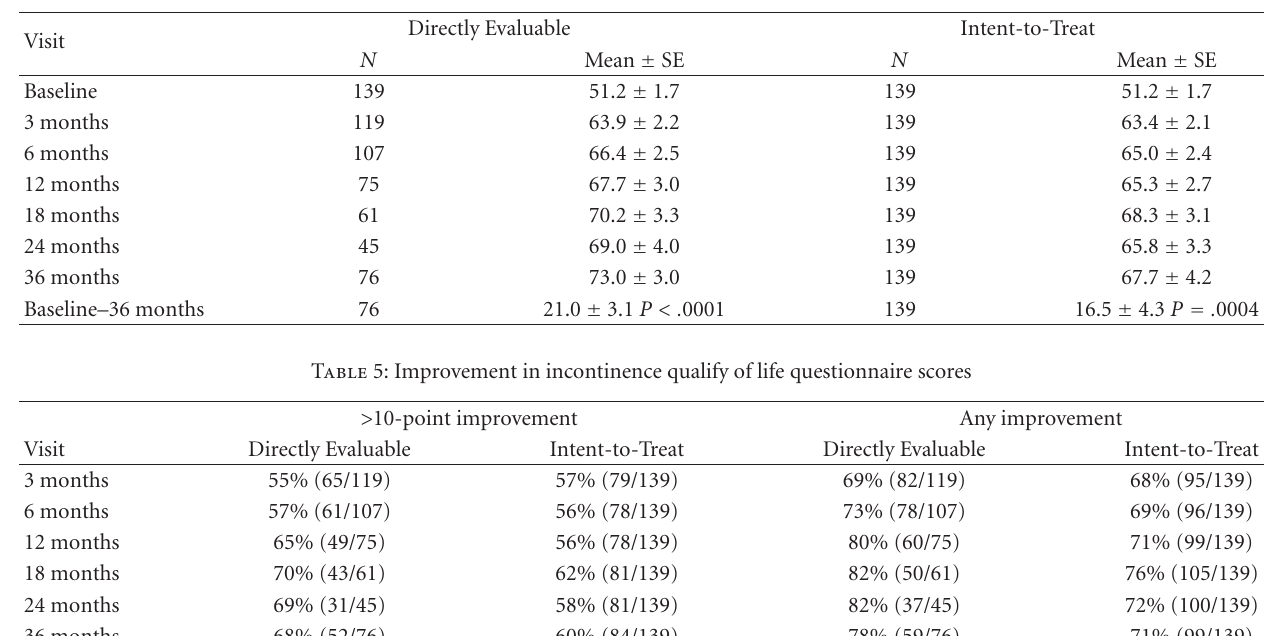
Table 4: Incontinence qualify of life questionnaire results.